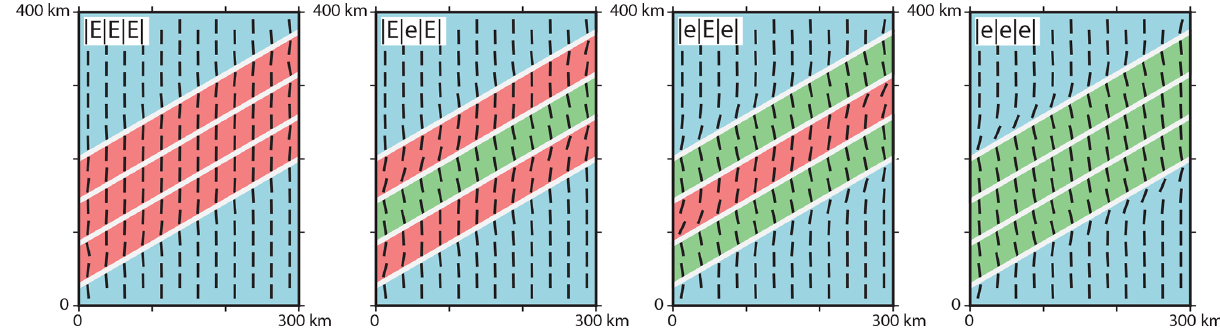
Figure 10. Influence of Young’s modulus in interaction with low-friction faults on the far-field stress orientation. Black bars represent the orientation of S Hmax at a depth of 1000m. Colours indicate the material properties used. The blue area uses the reference material properties, the green material uses a low Young’s modulus and the red material has a larger Young’s modulus; see Table 2. White lines indicate cohesionless vertical discontinuities (faults) with a friction coefficient of µ = 0 . 1.